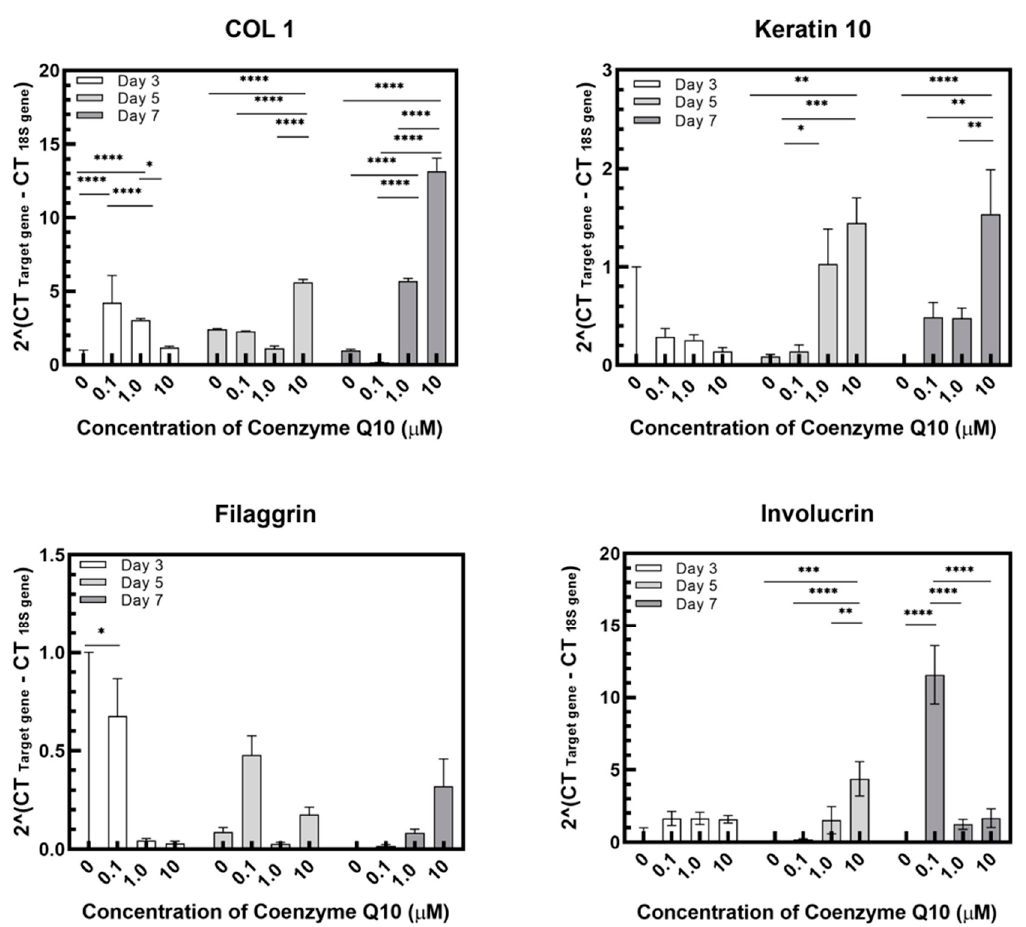
Figure 8. Relative gene expression of collagen 1, keratin 10, filaggrin, and involucrin in samples as a function of the coenzyme Q10 concentration after 3 days, 5 days, and 7 days of air exposure ( p -value: * < 0.05, ** < 0.01, *** < 0.001, and **** < 0.0001).